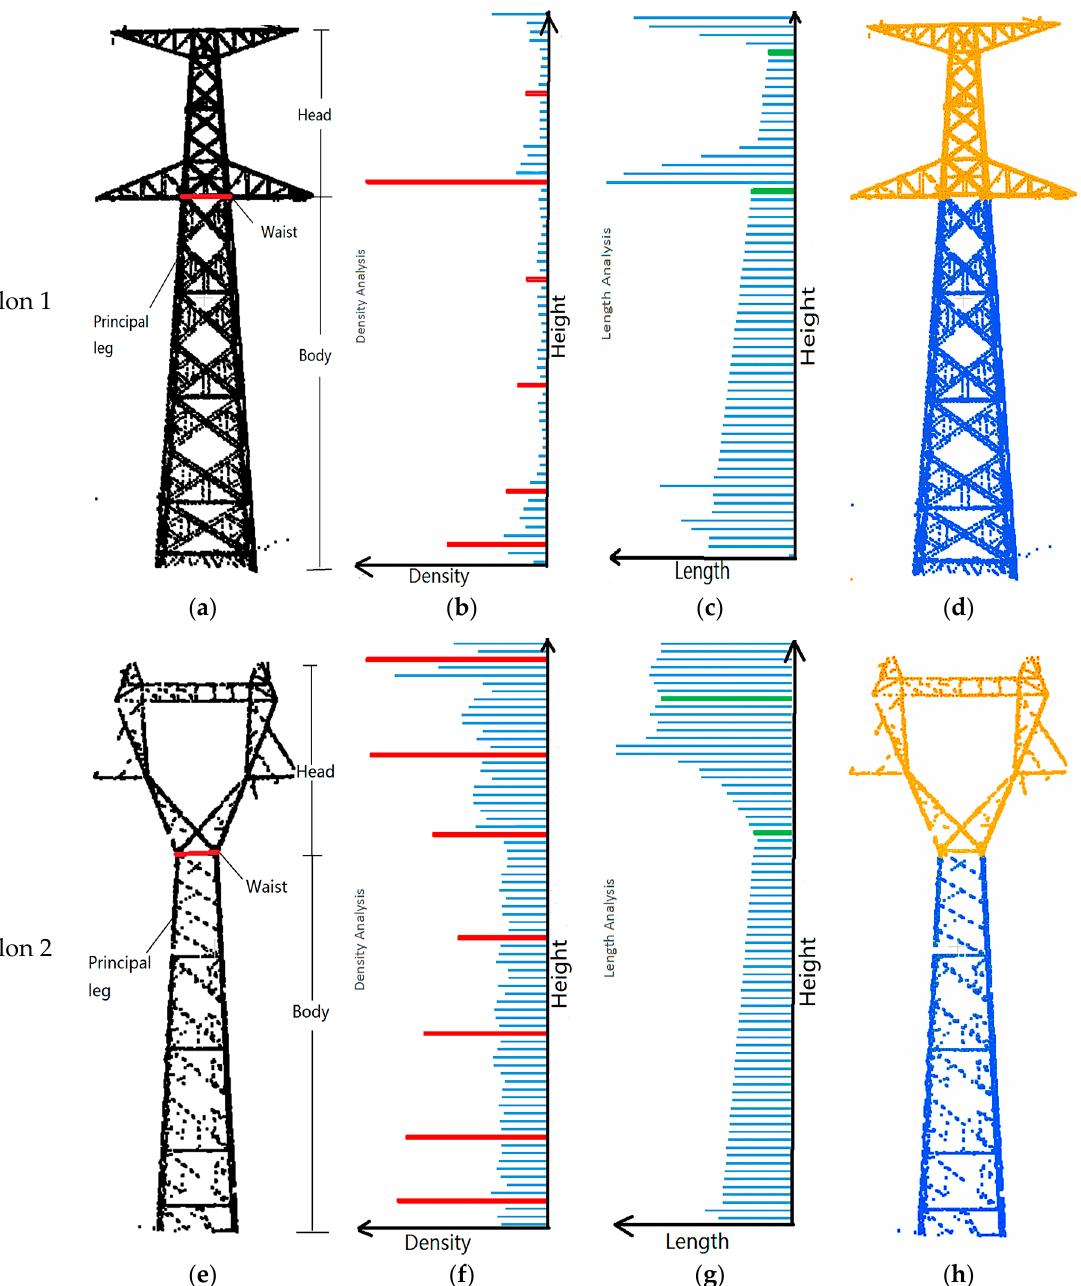
Figure 3. Pylon decomposition based on statistical analysis: ( a , e ) the original point cloud of extracted pylons, and the red planes are the waist plane; ( b , c , f , g ) statistical analysis results on density and length histogram, respectively; and ( d , h ) decomposition results.